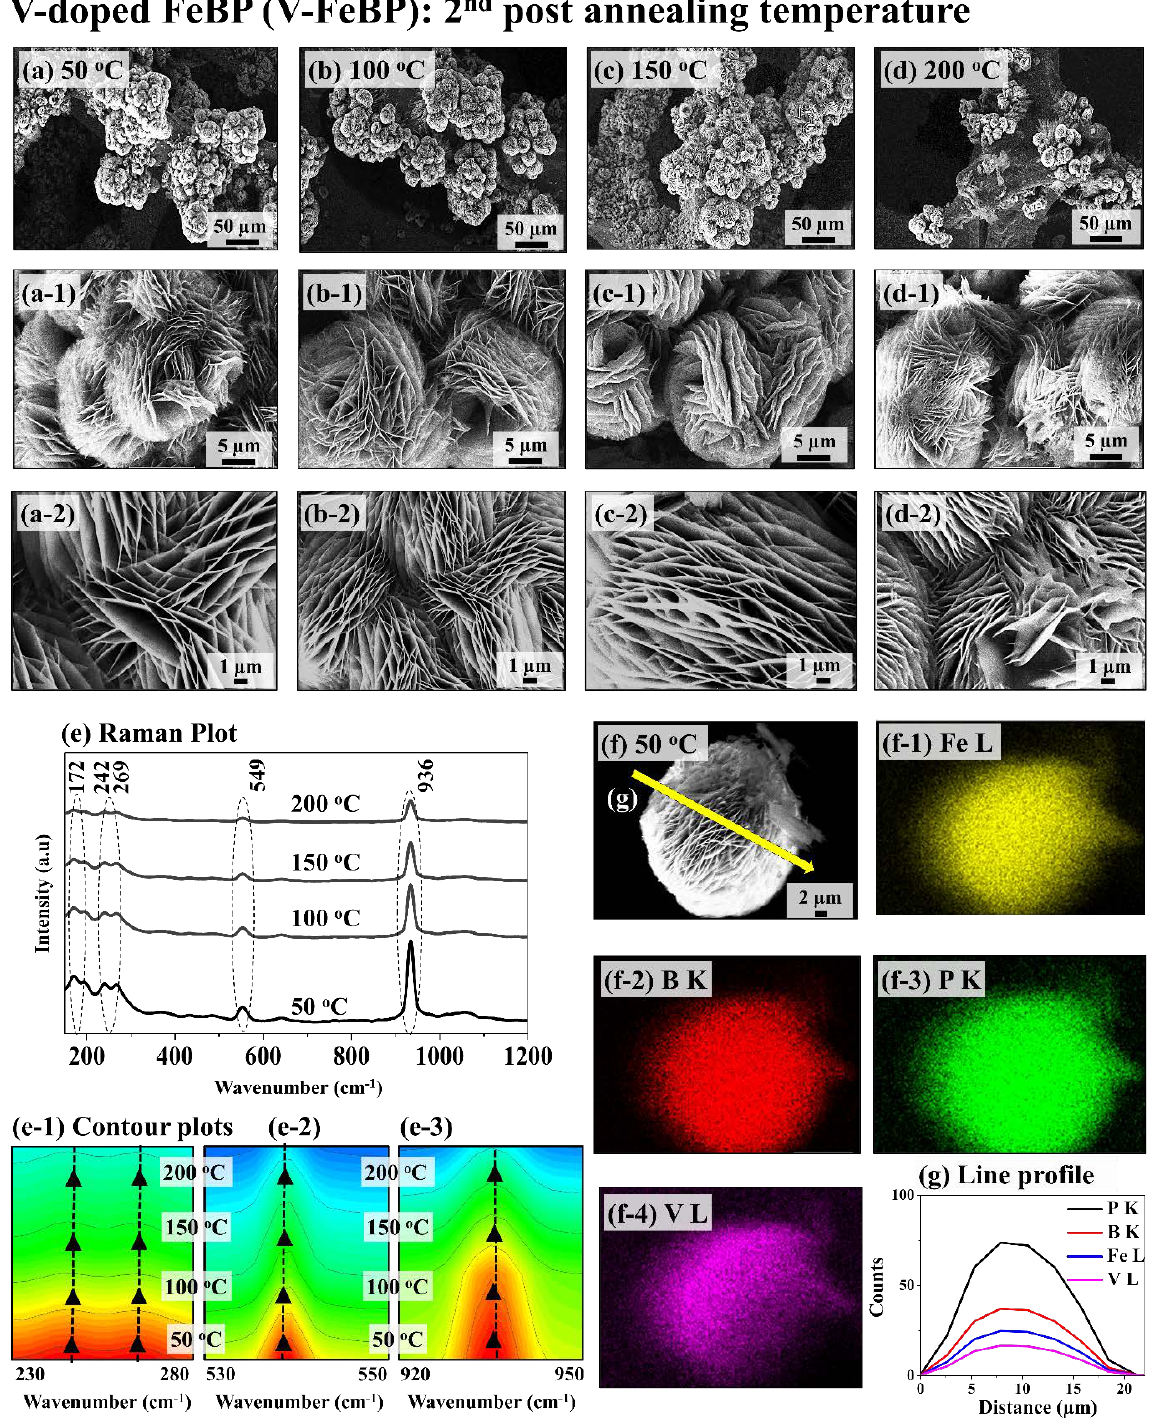
Figure 2. Post-annealing temperature variation (2nd annealing) of vanadium (V)-doped FeBP MSC electrodes between 50~200 °C for 15 min. The best FeBP was fabricated at 100 °C for 12 h with the 1 mM Fe, 3.6 mM H 3 BO 3 , 8.4 mM NaH 2 PO 2 and 20 mM CH 4 N 2 O. The best FeBP was post-annealed (1st) and doped with V by a soaking approach in 0.2 mM V solution for 15 min at room temperature. ( a )–( d ) SEM micrographs. ( a-1 )–( d-1 ) and ( a-2 )–( d-2 ) Magnified SEM images. ( e ) Raman plot. ( e-1 )– ( e-3 ) Contour plots of Raman peaks. ( f )–( f-4 ) EDS maps of Fe L, B K, P K and V L. ( g ) Corresponding EDS line profiles.